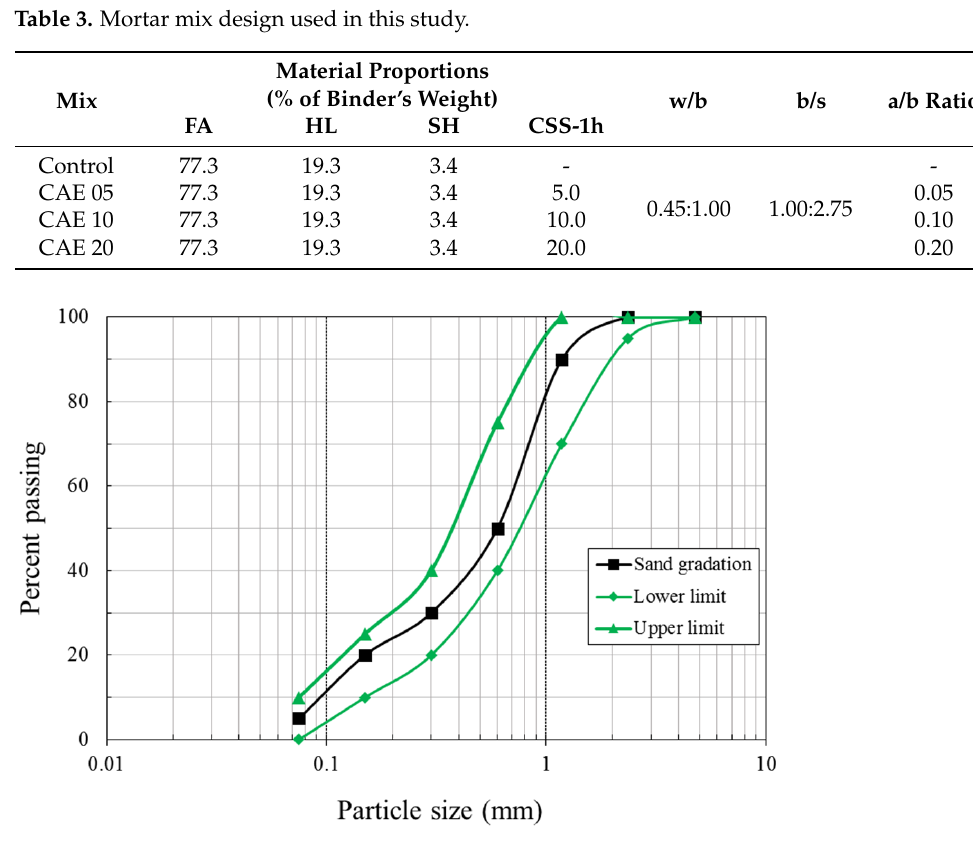
Table 3. Mortar mix design used in this study.